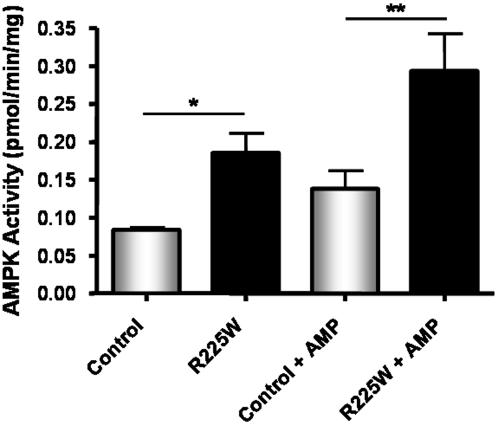
Basal and AMP-activated AMPK activities in differentiated skeletal muscle cells from R225W carriers and matched control subjects.Means +/− SD. n = 3, One-way ANOVA, Tukey post-test, *p = 0.015, **p = 0.001.